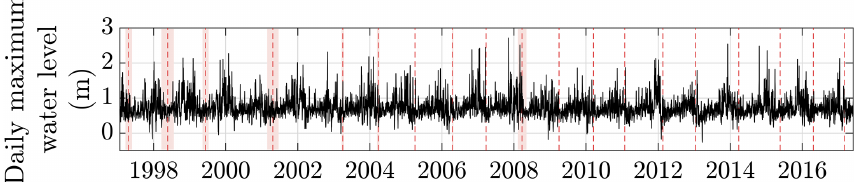
Figure 2. Daily maximum water level time series, including indications of the periods when the topographic surveys were executed. Dashed red lines represent the exact date used in the analysis, whereas the pink-shadowed region represent the potential period during which the measurements took place (only for surveys where the exact date were not available).